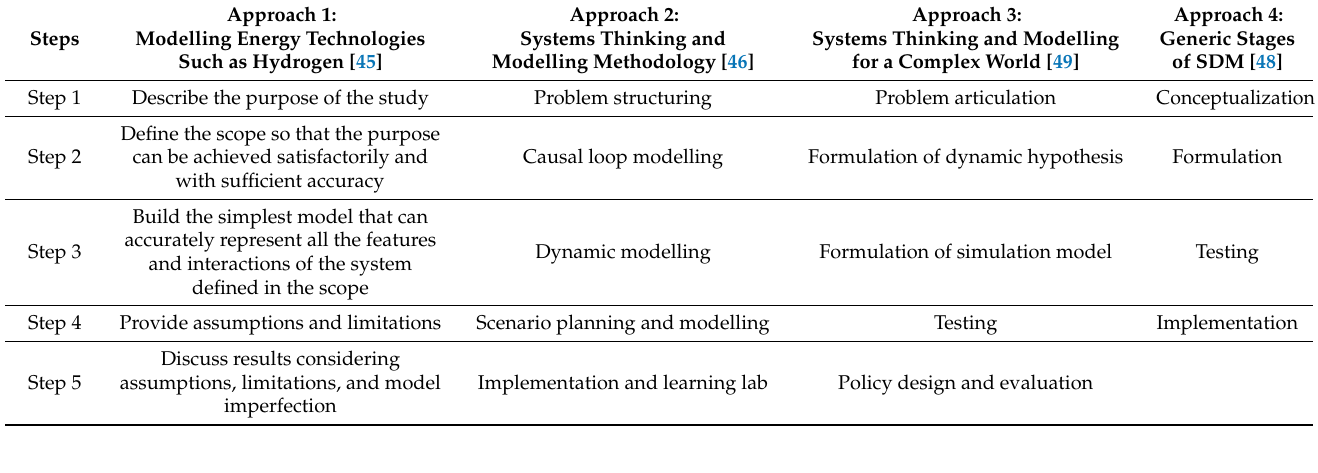
Table 1. Summary of various approaches to modelling.